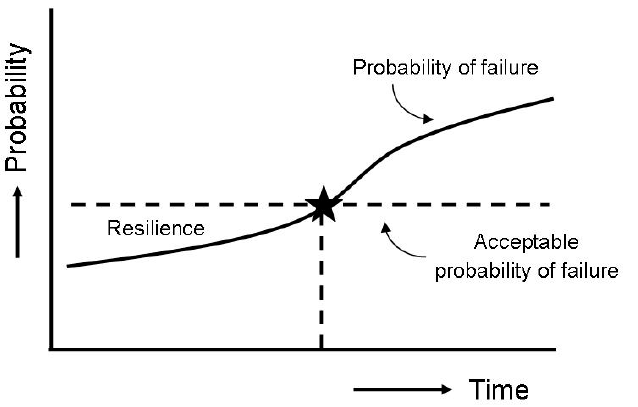
Figure 3. Comparison between the probability of failure of the considered system and the acceptable probability of failure, indicated by resilience (Huibregtse et al.,